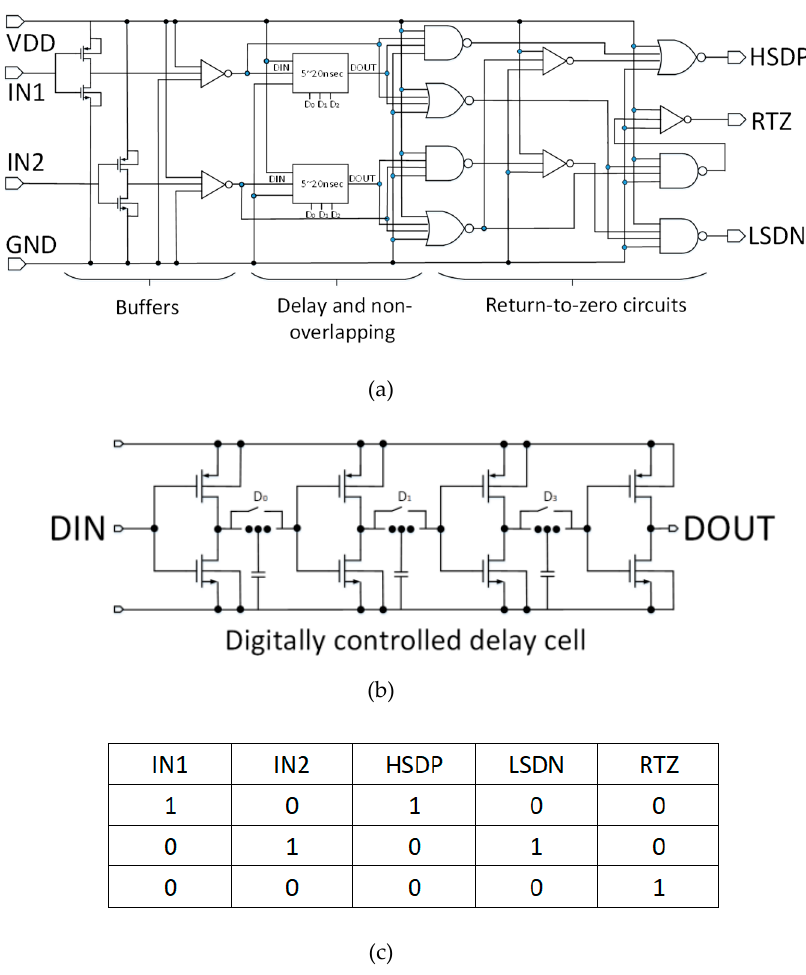
Figure 6. Input stage of the bipolar pulse driver ( a ), the digitally controlled delay element ( b ), and the truth table of the control signal versus the inputs ( c ), where DIN and DOUT presents the control signal fed before and after the delay element.